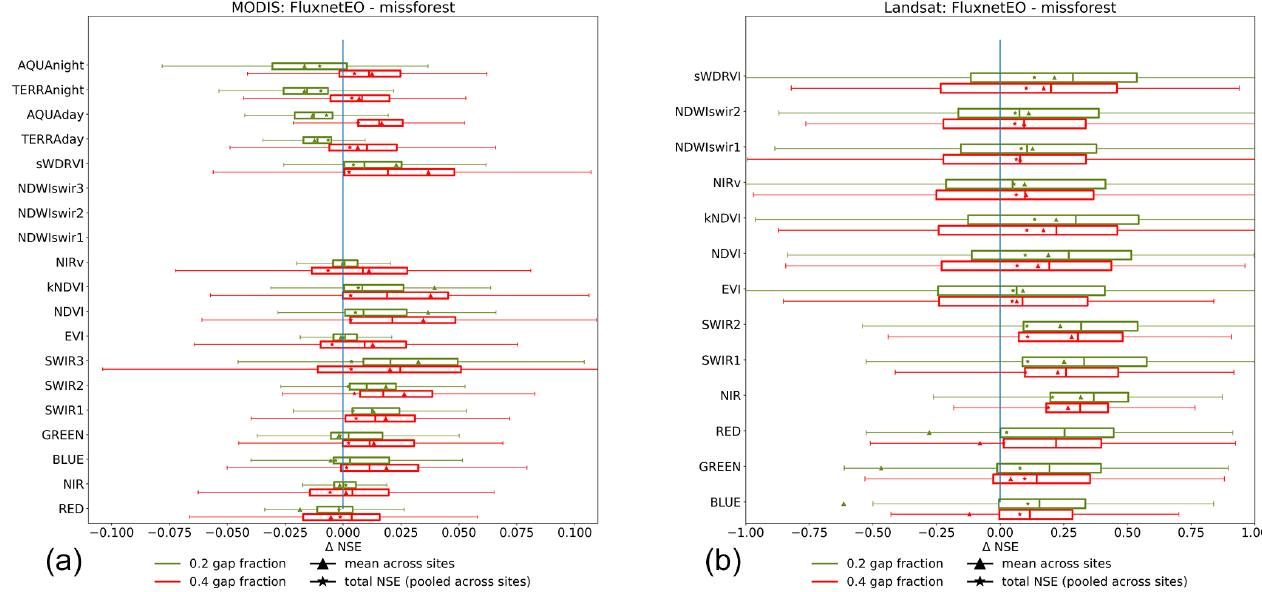
Figure 7. Benchmarking in artificial gaps: distribution of NSE per site of the gap-fill estimates in artificial gaps by FluxnetEO compared to missForest within the physical ranges of the indices for 20% and 40% of good-quality data removed. For MODIS (a) and Landsat (b) , random good-quality samples are removed from the tower